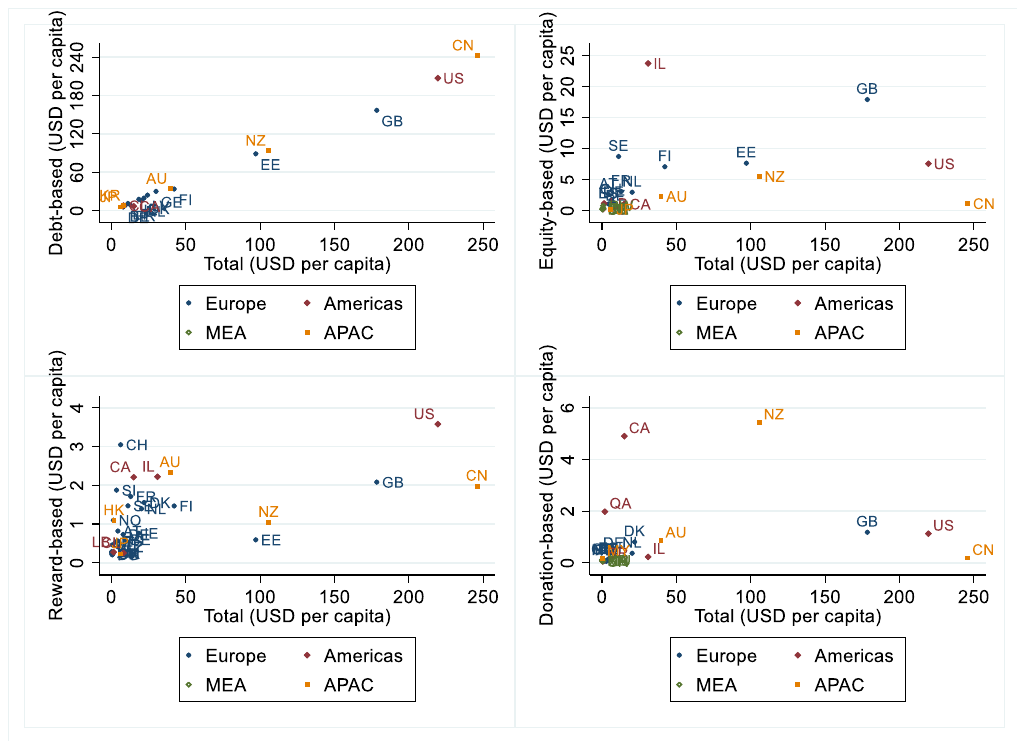
Figure 1. Total crowdfunding volumes during 2015–2016 per capita by types of crowdfunding across